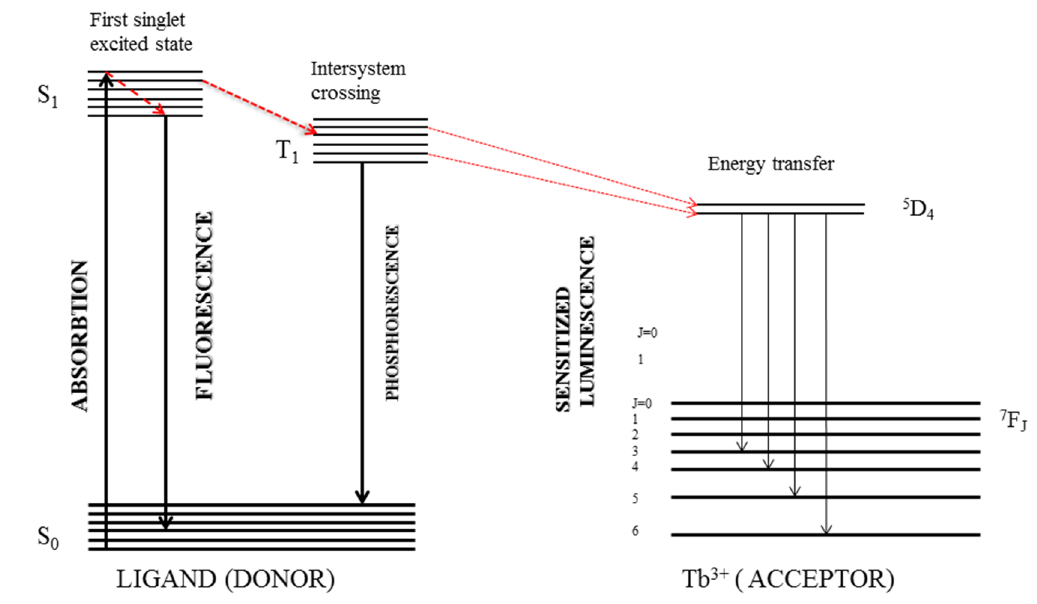
3 + , with permission from